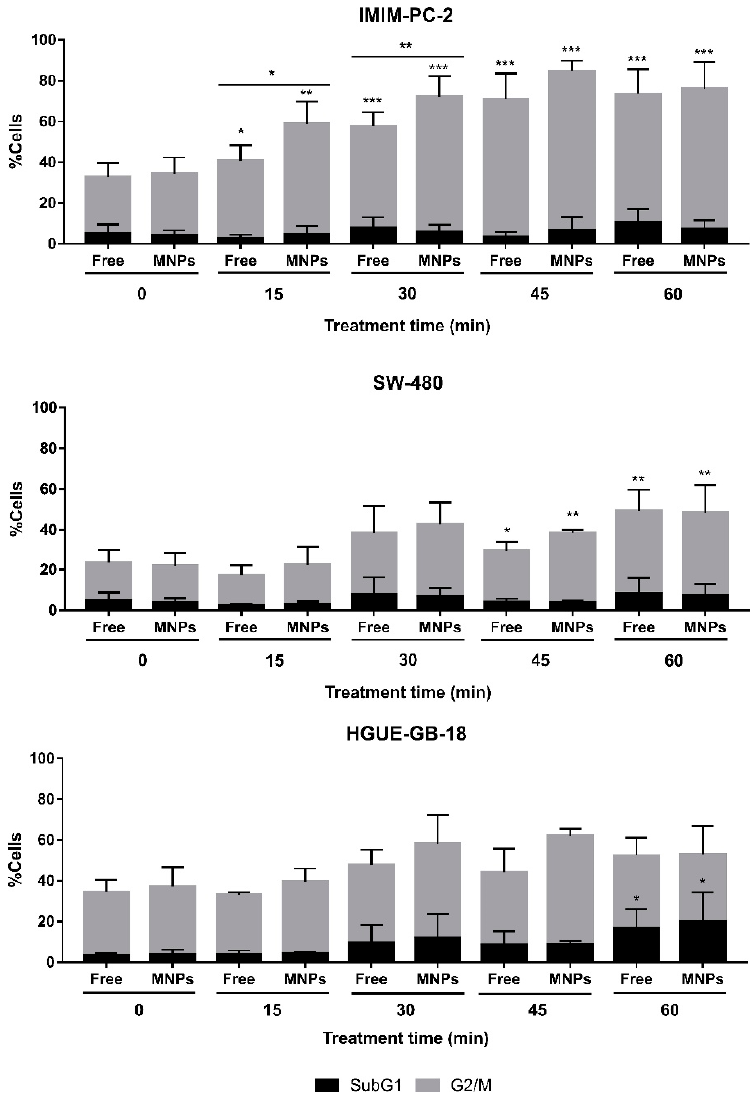
Figure 5. Cells accumulation in subG1 and G2/M phases after a CLytA-DAAO, free or bound to MNPs, and D-Ala treatment in IMIM-PC-2 pancreatic carcinoma cell line, SW-480 colorectal carcinoma cell line, and HGUE-GB-18 glioblastoma cell line. Cells were treated with 2 U/mL CLytA- DAAO and 1 mM D-Ala for a short time (15–60 min) and then, treatment was removed, replacing the medium. Cells were incubated until 24 h from the treatment addition were completed. Graph shows the percentage of cells ± SD in subG1 and G2/M phases ( n ≥ 3). * indicates a p -value < 0.05, ** < 0.01 and *** < 0.001.